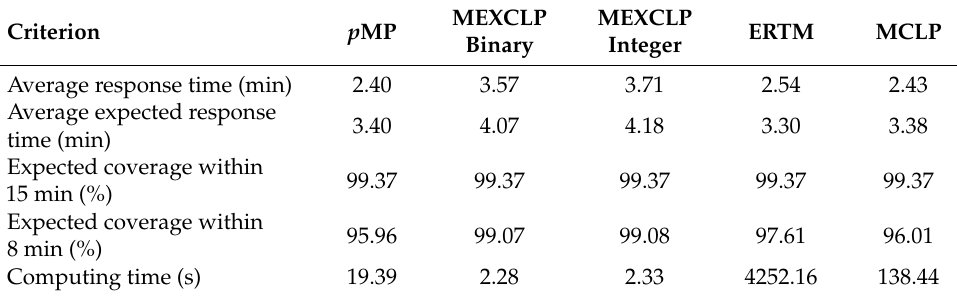
Table 4. Static evaluation of the location models, street model of demand.